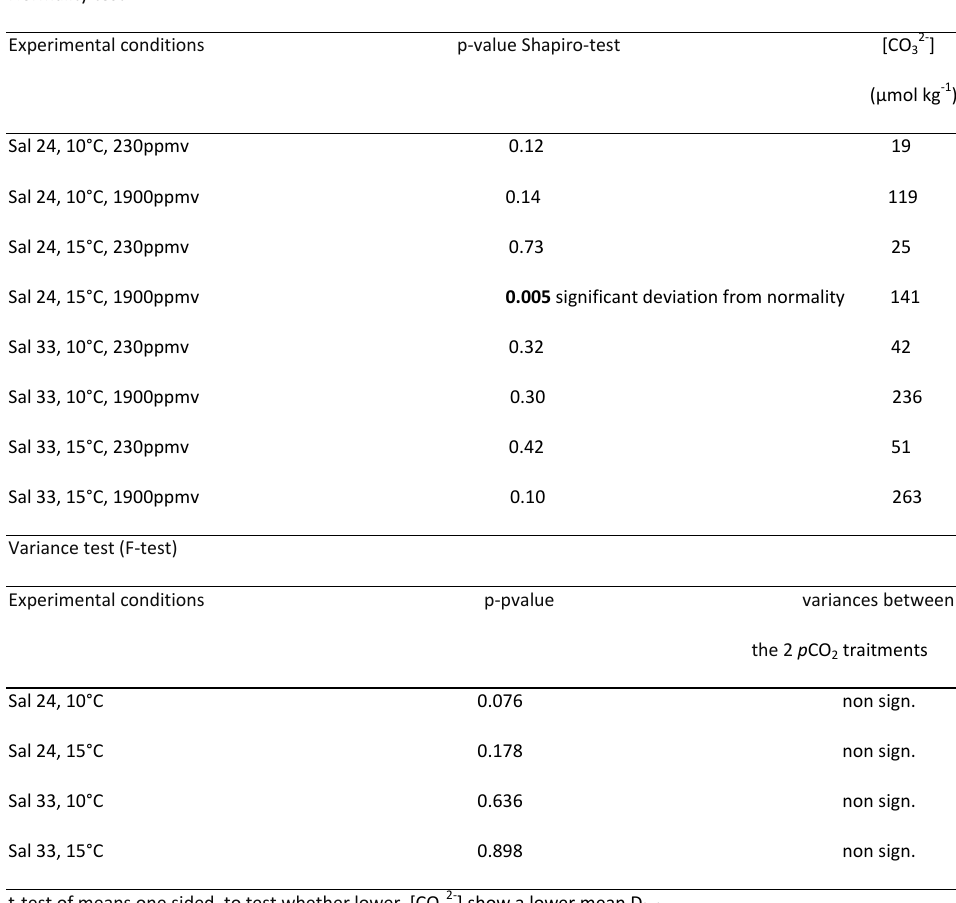
Table 5. Statistical test (Shapiro-test, F-test, and t-test) applied to DSr values, using statistic program R (R Development Core Team (2005); http://www.r-project.org).